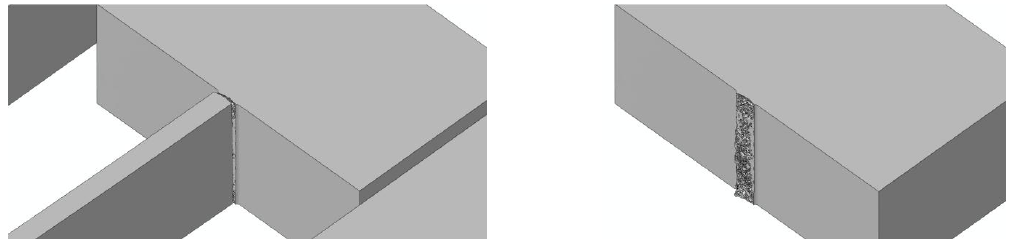
Figure 13. Failure mechanism induced by the bending-dominated loading (side-A drop).